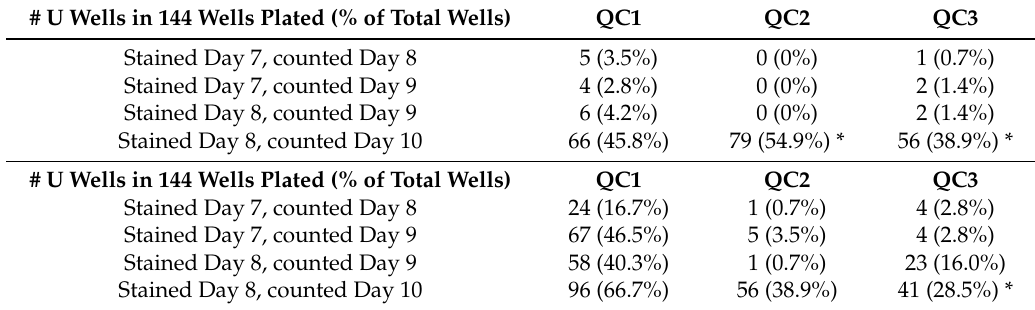
Table 6. Day 10 monolayers become fragile and deteriorate, increasing the number of uncountable (U) wells across all dilutions plated in the assay.